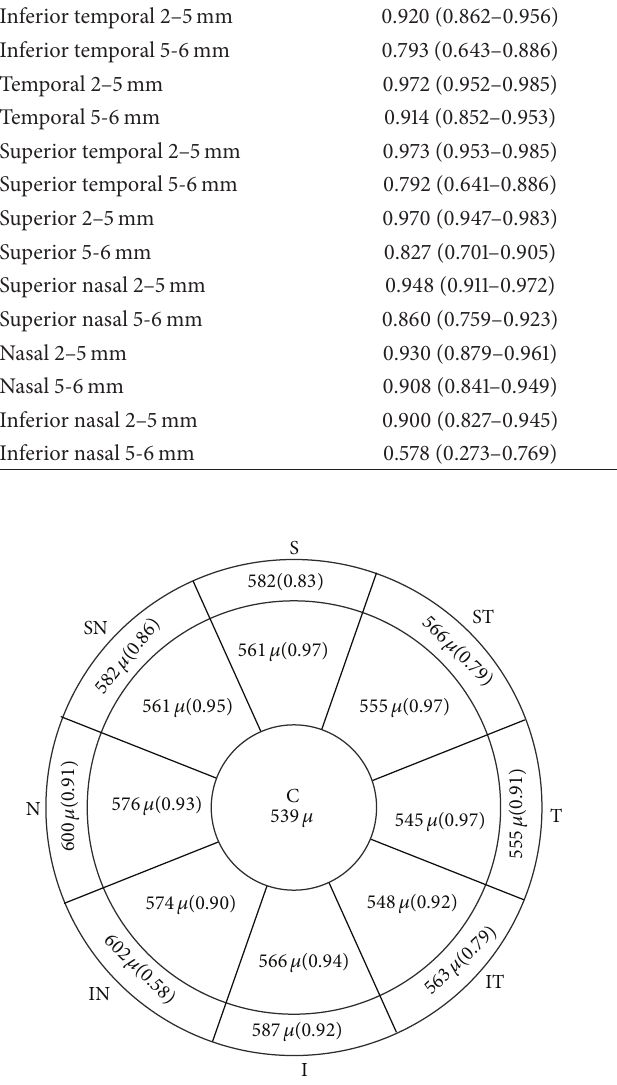
Figure 5: A figure showing peripheral corneal thickness in the 2–5 mm and 5-6 mm zones. The ICC values are shown after the measurements in